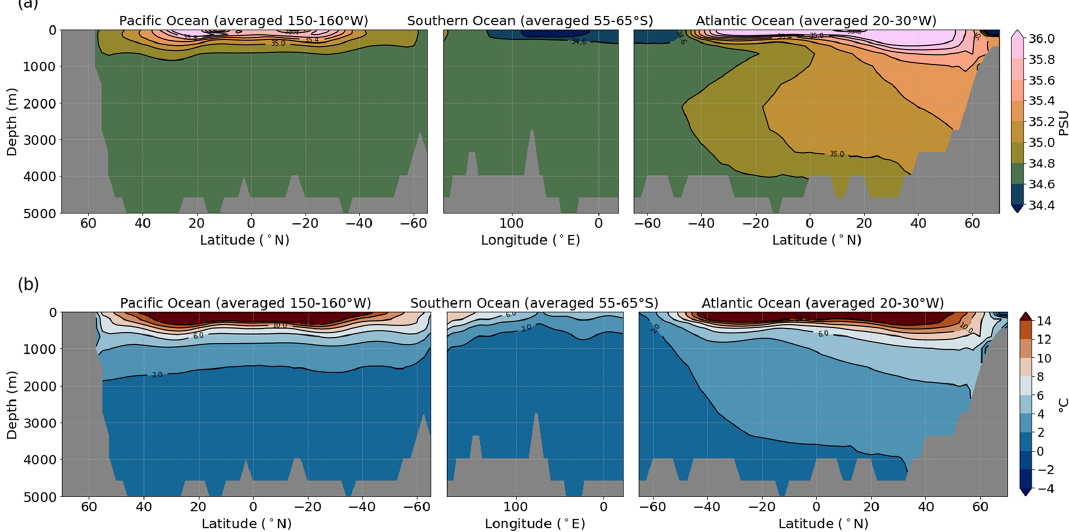
Figure 2. (a) Salinity and (b) temperature profiles for the control simulation (centennial mean from final 100 years of a 5000-year simulation) along a transect crossing the Pacific–South Atlantic